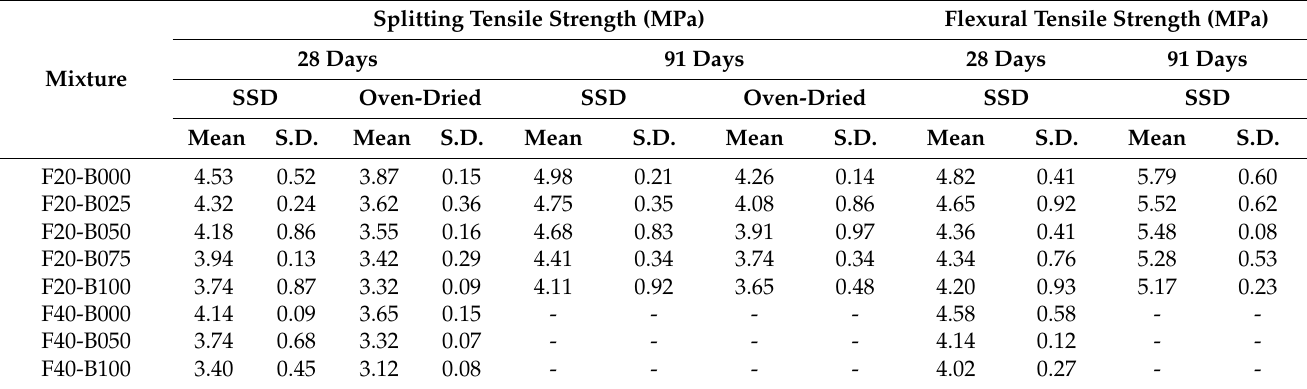
Figure 9. Splitting tensile strength test results. Table 5. Splitting and flexural tensile strength